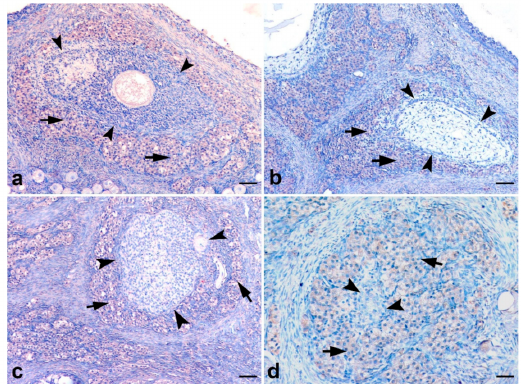
Figure 8. AMHRII immunopositivity in the feline ovary. ( a – d ); atretic follicles in different stages (arrow heads) and AMHRII immunopositive luteal cells surrounding these follicles (arrows) SABP immunostaining, AEC chromogen, Mayer’s hematoxylin counterstaining, ( a – c ) × 140, ( d ) × 280. Scale bar ( a – c ) = 60 µ M and ( d ) = 30 µ